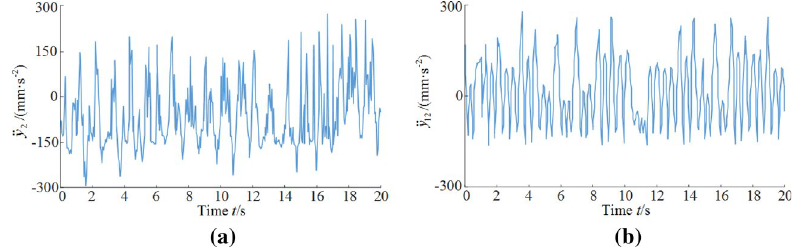
Figure 6. Vibration acceleration curve of the key parts of the shearer: ( a ) front rocker arm; ( b ) front walking box.